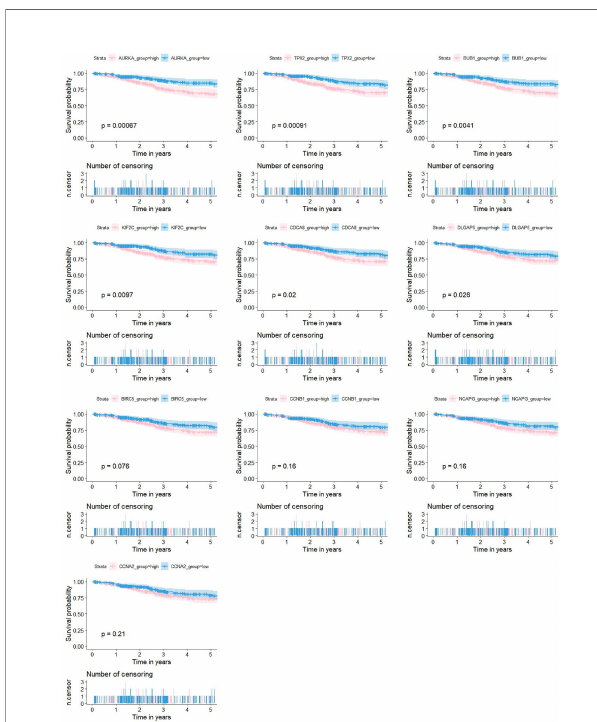
FIGURE 8 | Exploration of the possible pathogenesis of 6 hub genes (AURKA, BUB1, CDCA8, DLGAP5, KIF2C and TPX2) in UCEC by using the GSEA algorithm. 5 common functional gene sets, ‘ Cell cycle ’ , ‘ DNA replication ’ , ‘ Mismatch repair ’ , ‘ Homologous recombination ’ and ‘ Oocyte meiosis ’ , were signi fi cantly enriched in UCEC samples with high gene